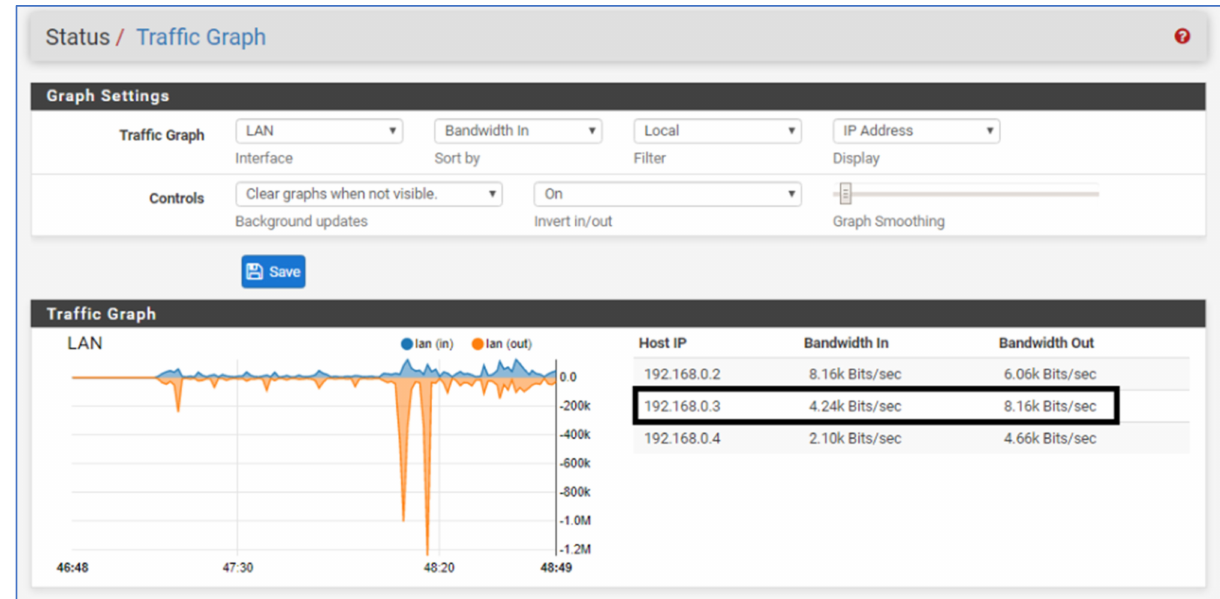
Figure 3. Screenshot of firewall (pfSense) traffic passing of smartphone with IP address.